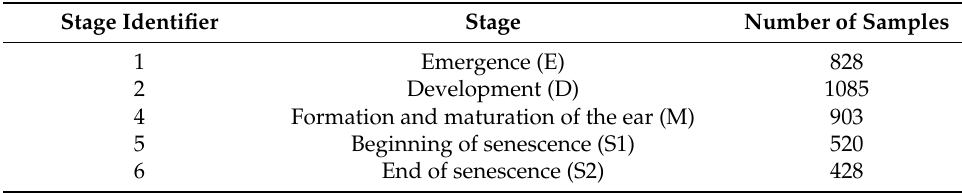
Table 3. Number of samples per class for five phenological stages.